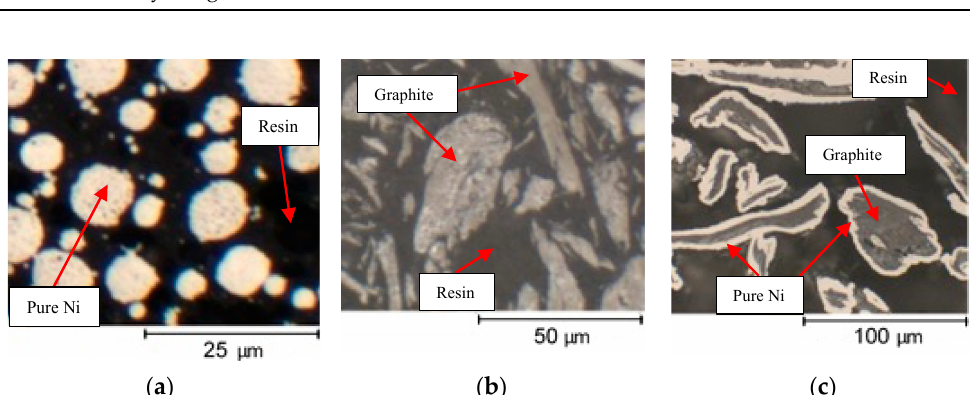
Figure 2. Micrographs showing polished cross sections of nickel ( a ), graphite ( b ), and NCG ( c ) powders.